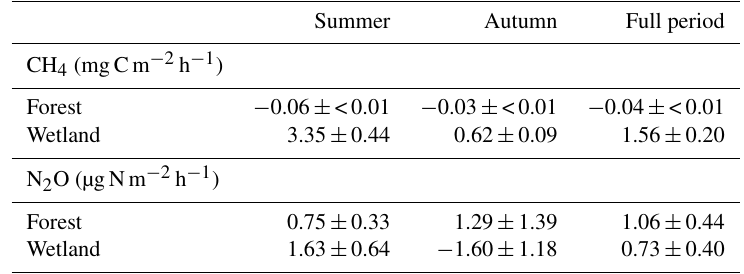
Table 1. Mean ± SE CH 4 and N 2 O fluxes split by both campaign period (summer, autumn) and site (forest, wetland).